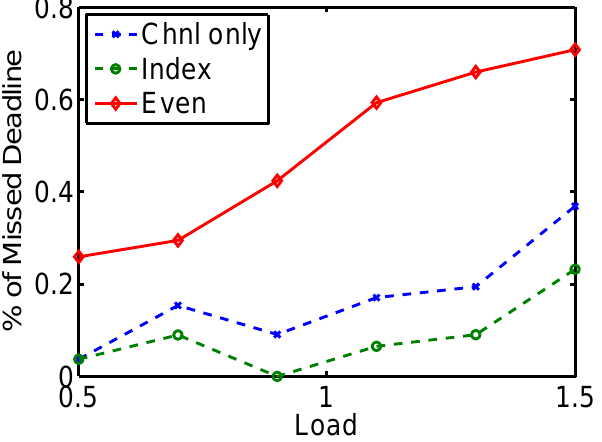
Figure 8. Percentage of Jobs Missed Deadline when Index Policy Objective is Minimizing Missed Deadlines, Real-life Trace